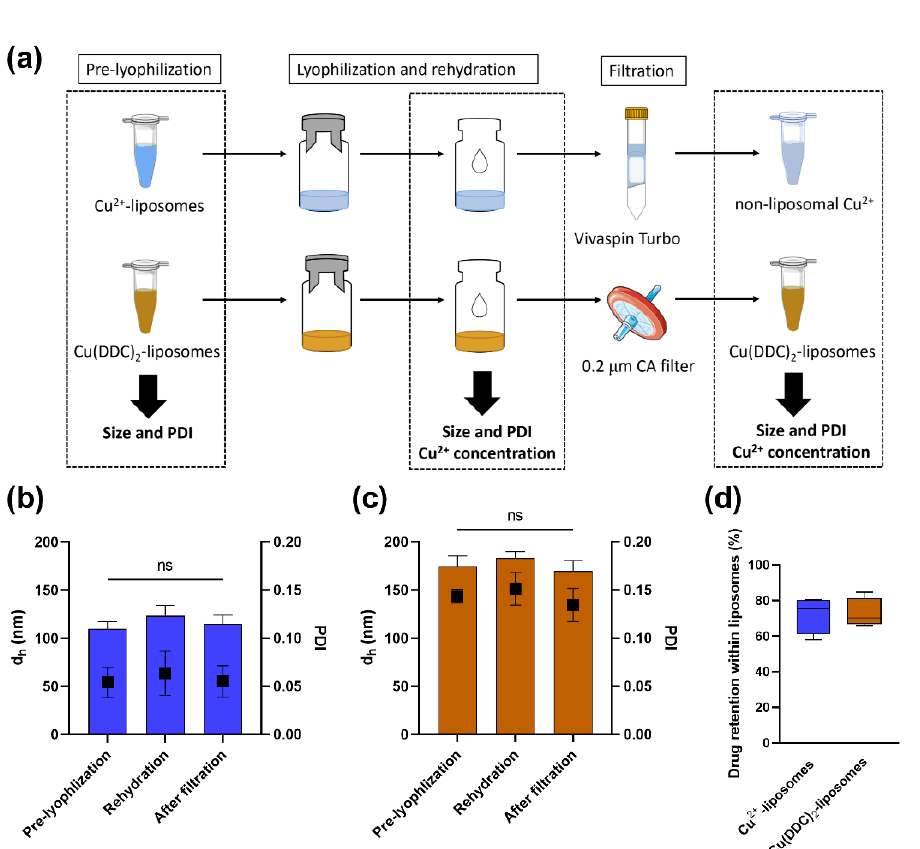
Figure 1. Effect of the lyophilization processes on Cu 2+ -liposomes (blue) and Cu(DDC) 2 -liposomes (brown) characteristics. ( a ) Experimental procedure of characterization steps prior and following the lyophilization process. The filtration step separated non-encapsulated Cu 2+ and Cu(DDC) 2 . Hydrodynamic diameter (d h ; bars) and polydispersity index (PDI; squares) were determined prior to lyophilization, after rehydration and following filtration. Total Cu 2+ concentrations were determined after rehydration, while Cu 2+ concentrations of separated non-encapsulated Cu 2+ and Cu(DDC) 2 -liposomes were determined following filtration and were used to calculate drug retention (%). d h and PDI of ( b ) Cu 2+ -liposomes and ( c ) Cu(DDC) 2 -liposomes prior to lyophilization, when rehydrated and following filtration. ( d ) Drug (Cu 2+ or Cu(DDC) 2 ) retention within Cu 2+ -liposomes or Cu(DDC) 2 -liposomes after lyophilization. Data are expressed as the mean ± standard deviation (n = 4; repeated measures 1-way ANOVA: ns = not significant p > 0.05). CA = cellulose acetate.